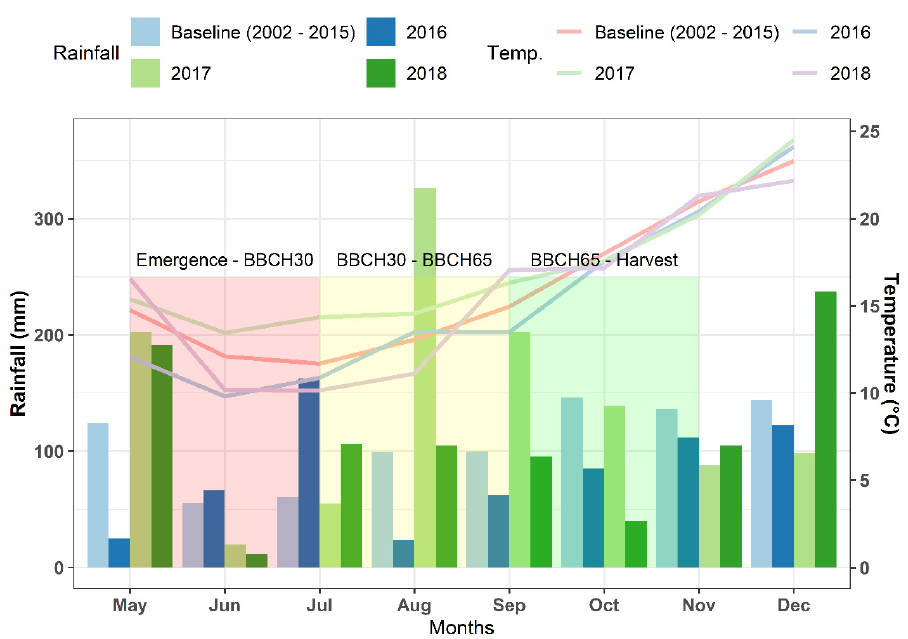
Figure 1. Total monthly rainfall and average monthly temperatures for the 2016, 2017, and 2018 seasons in relation to the baseline (2002–2015). BBCH30: Beginning of stem elongation of rosette growth; BBCH65: Full flowering: 50% of flowers opened.